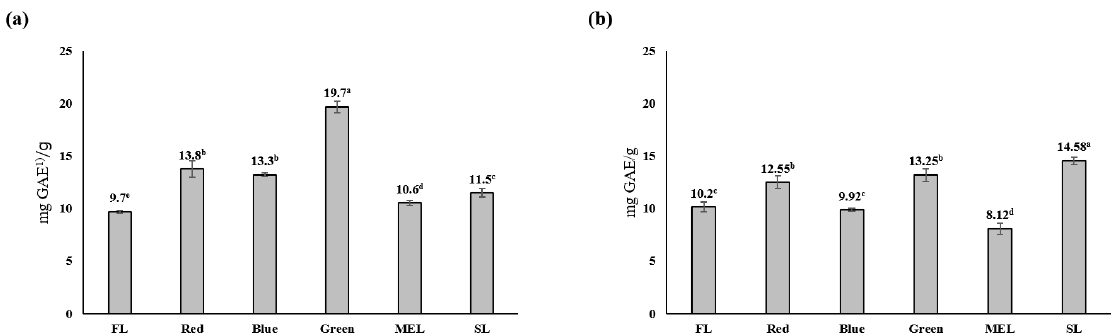
Figure 3. Total phenolic contents of aerial ( a ) and underground ( b ) parts from extracts of Dachul under different light sources. (1) GAE; gallic acid equivalents. Values represent mean of data obtained from three independent experiments ( p < 0.05).